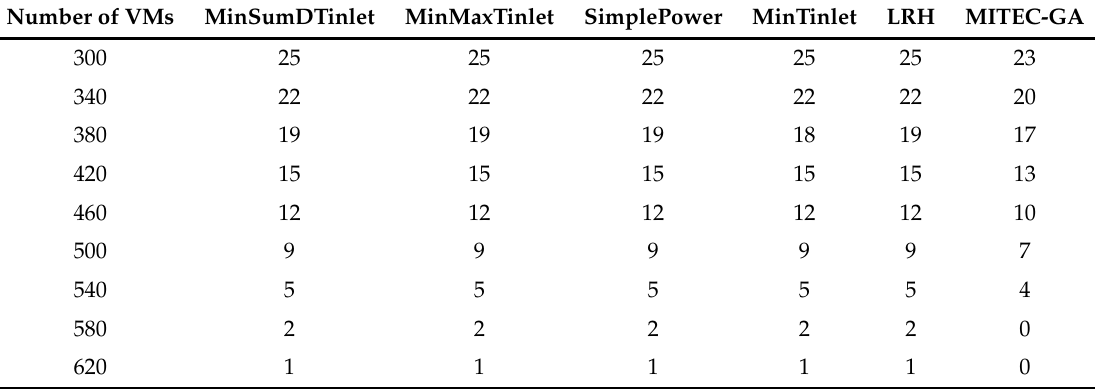
Table 1. Numbers of off-chassis in different VM allocation algorithms for different numbers of VMs. Number of VMs MinSumDTinlet